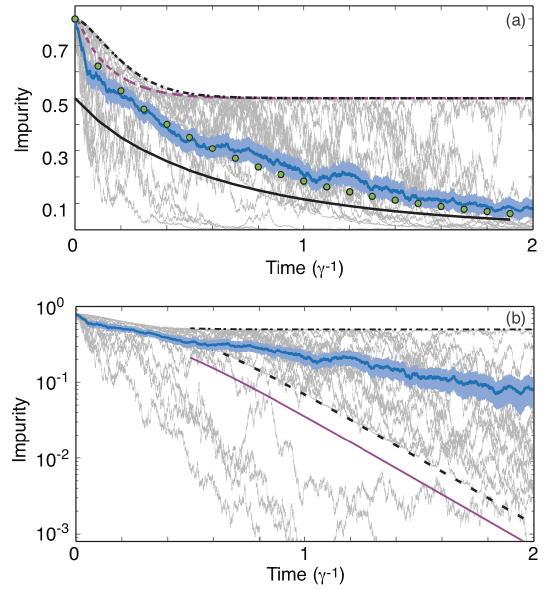
FIG. 19. Short-time impurity dynamics for D ¼ 5 . We plot 20 impurity trajectories (gray) and the ensemble average of the trajectories (dark blue). The error bars for the ensemble average, (cid:4) (cid:10) , are smeared around the mean (light blue). Time is mean measured in units of (cid:2) (cid:2) 1 . (a) Linear abscissa. The dashed magenta and dash-dotted black lines are approximate upper bounds on the L trajectories; see Appendix A 4 for further explanation. The solid black line is the exact mean impurity for the case of a qubit, i.e., Eq. (A16). The circles are h L i for D ¼ 5 , i.e., Eq. (A10). (b) The impurity is plotted on a logarithmic axis; this helps to show the approximately exponential decrease in impurity predicted by Eq. (A10). The approximate upper bound on the spread of L trajectories is the dash-dotted black line. The dashed black line corresponds to the most likely trajectories. Below the solid magenta line, there is only 1 =D of the ensemble of trajectories at long times. These lines are explained in Appendix A